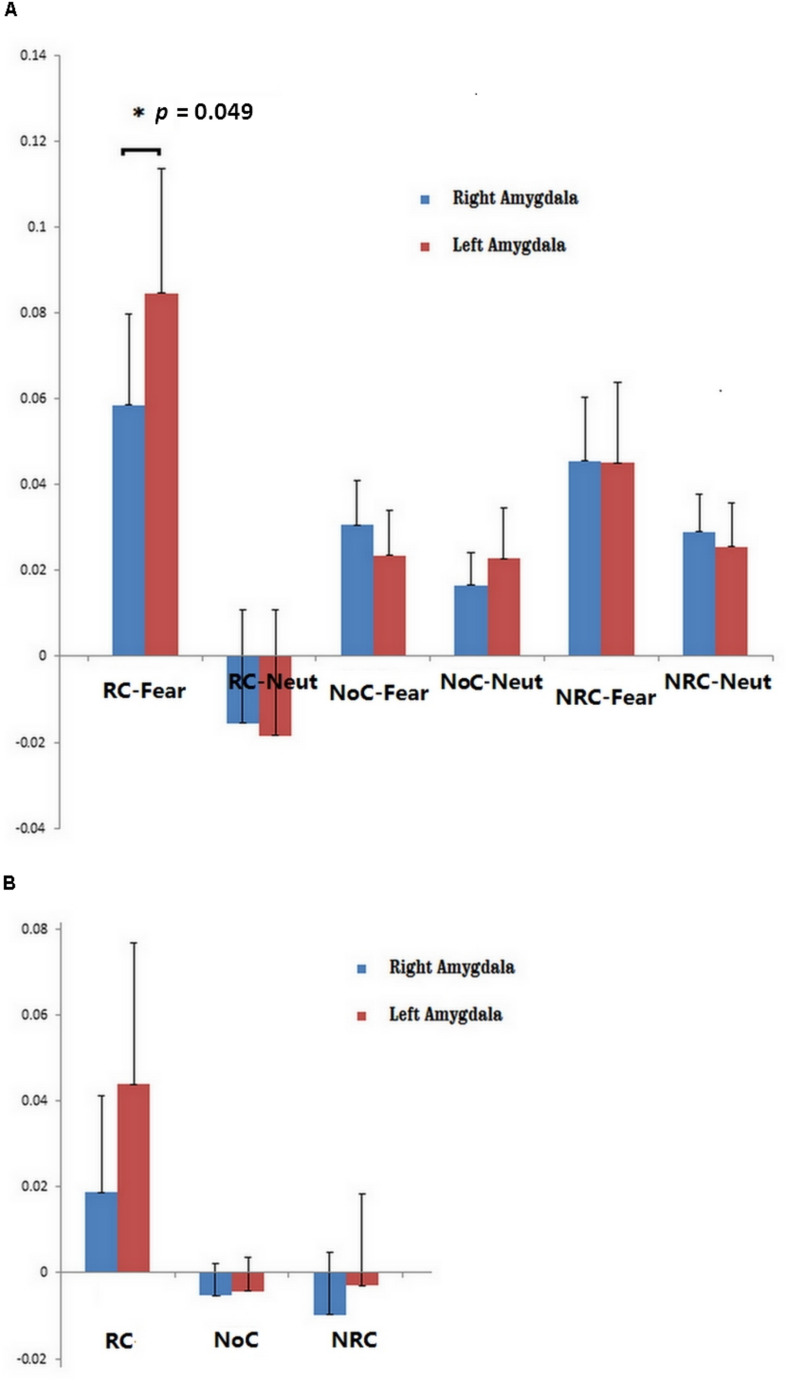
(A) ROI analysis of left and right amygdala activity during six conditions: RC-Fear, religious chanting while viewing fearful pictures; RC-Neut, religious chanting while viewing neutral pictures; NoC-Fear, no chanting while viewing fearful pictures; NoC-Neut, no chanting while viewing neutral pictures; NRC-Fear, non-religious chanting while viewing fearful pictures; and NRC-Neut, non-religious chanting while viewing neutral pictures (p < 0.05, uncorrected). (B) ROI analysis of left and right amygdala activity during three conditions: RC, religious chanting without viewing IAPS pictures; NoC, no chanting without viewing IAPS pictures; and NRC, non-religious chanting without viewing IAPS pictures. The error bars represent the standard error of the mean.